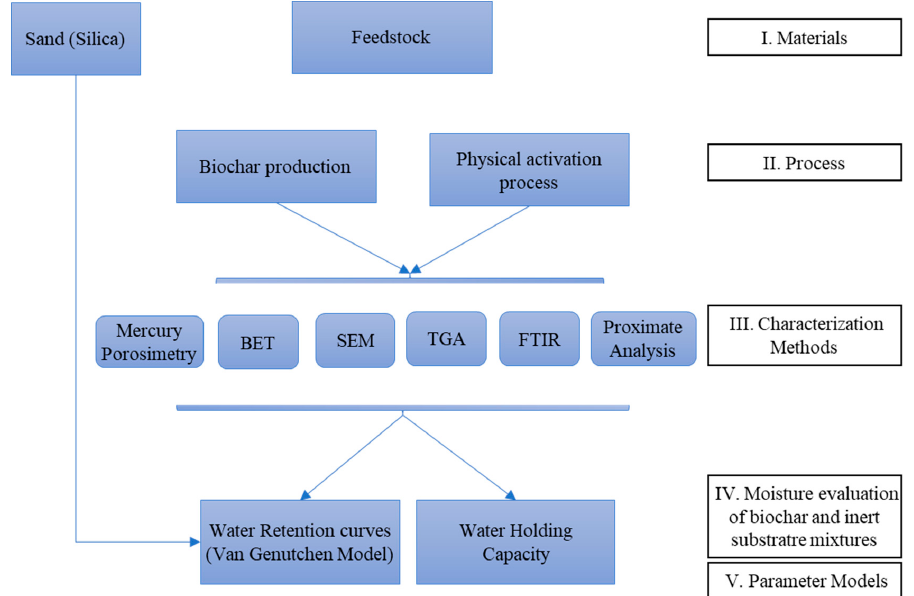
Figure 2. Scheme of methodology for biochar production, characterization, and performance eval- uation. Table 1 . Breakdown of the percentages by volume used between biomass/biochar and sand .